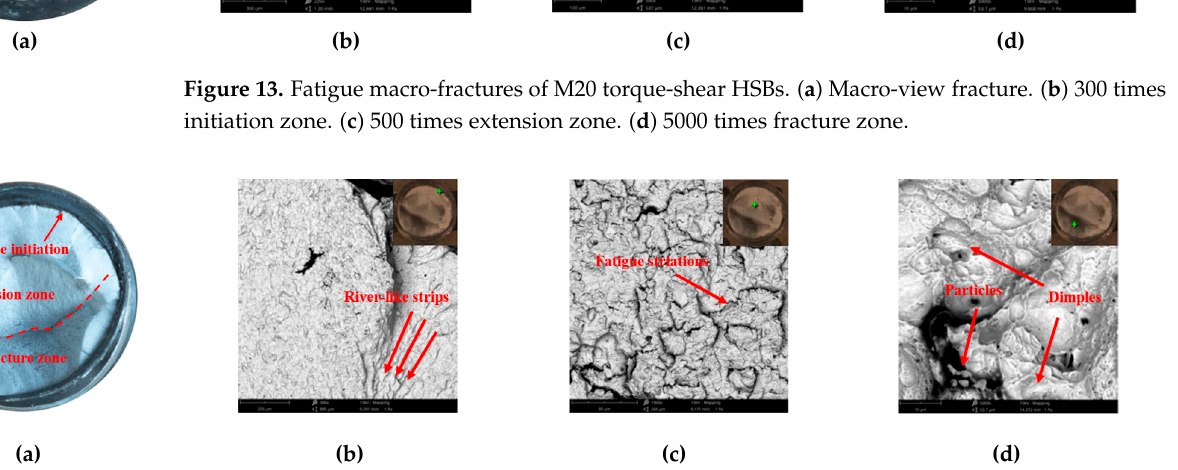
Figure 14. Fatigue macro ‐ fractures of M20 torque ‐ shear HSBs. ( a ) Macro ‐ view fracture. ( b ) 300 times initiation zone. ( c ) 1000 times extension zone. ( d ) 5000 times fracture zone.